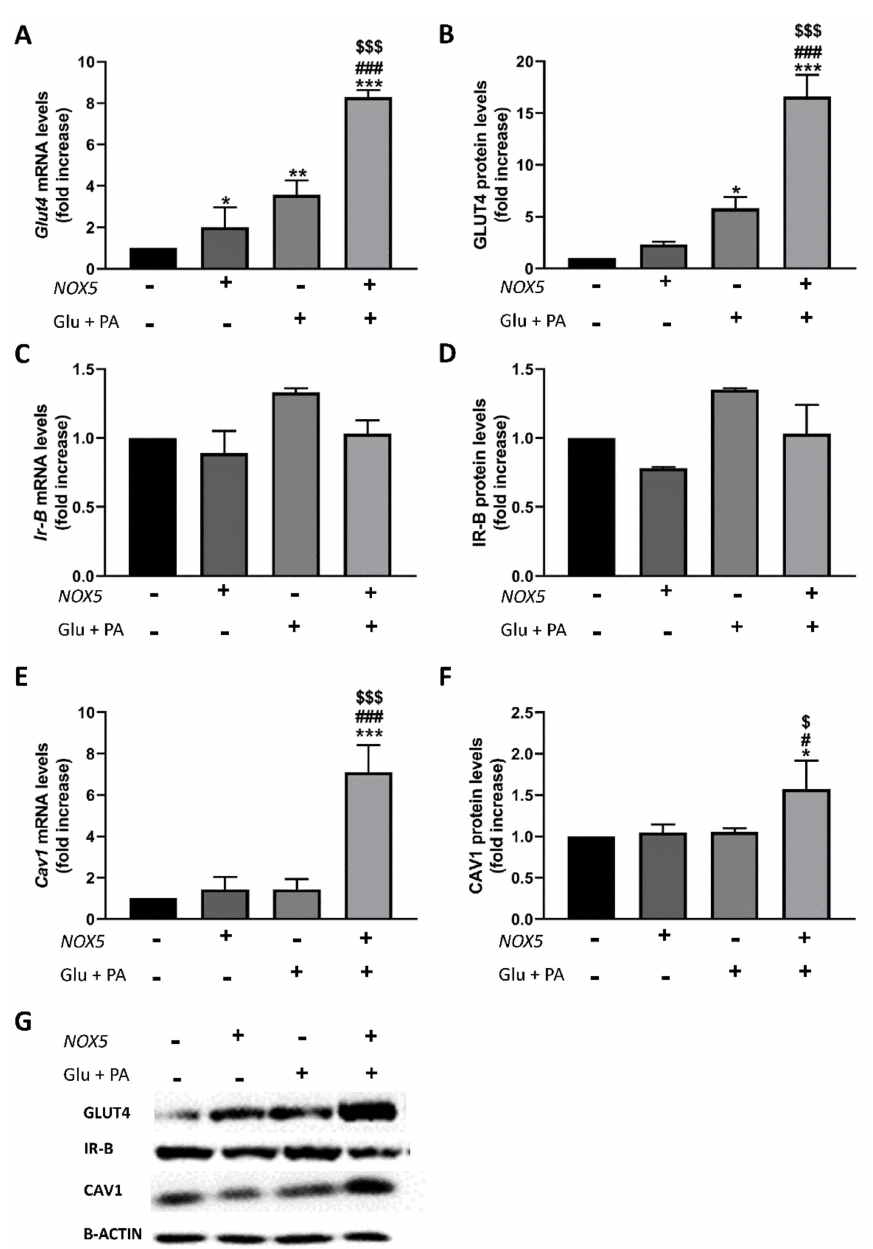
Figure 7. Glut4 and Cav-1 expression was increased in 3T3-L1 adipocytes when incubated for 24 h with Glu + PA conditioned media from NOX5-expressing endothelial bEnd.3 cells. ( A , C , E ) Glut4, Ir-B, and Cav1 mRNA levels of 3T3-L1 adipocytes ( n = 3). ( B , D , F ) GLUT4, IR-B, and CAV1 protein levels of 3T3-L1 adipocytes ( n = 3). ( G ) Representative images of Western blot for GLUT4, IR-B, and CAV1. mRNA levels are relative to GAPDH; protein levels are relative to β -actin. Fold increase is relative to the control group (Nox( − )/Glu + PA( − )). Values are expressed as mean ± SEM; * p < 0.05, ** p < 0.01, *** p < 0.001: differences relative to Nox( − )/Glu + PA( − ); # p < 0.05, ### p < 0.001: differences relative to Nox(+)/Glu + PA(-); $ p < 0.05, $$$ p < 0.001: differences relative to Nox( − )/Glu + PA(+). Statistical test used: